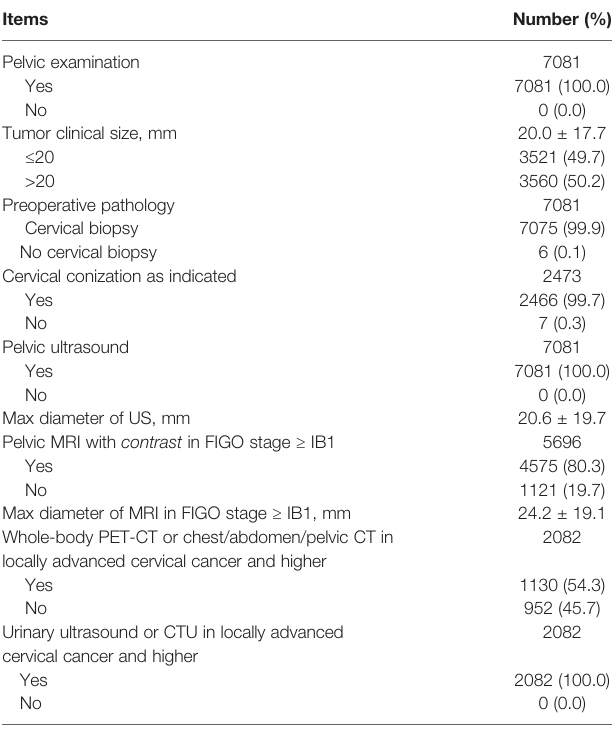
TABLE 4 | Characteristics of the preoperative assessment of patients. Items